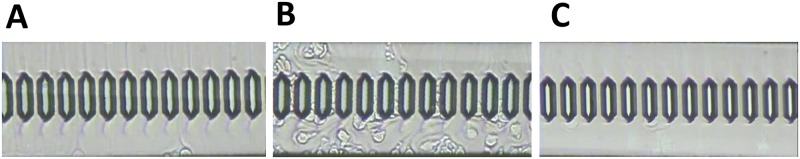
Flow path at the time of measurement.Flow path at the time of measurement with MC-FAN. (A) Flow channel images of 0 mM ACD with 0 mM L-cysteine, (B) 5 mM ACD with 0 mM L-cysteine, and (C) 5 mM ACD with 2.5 mM L-cysteine treatments.